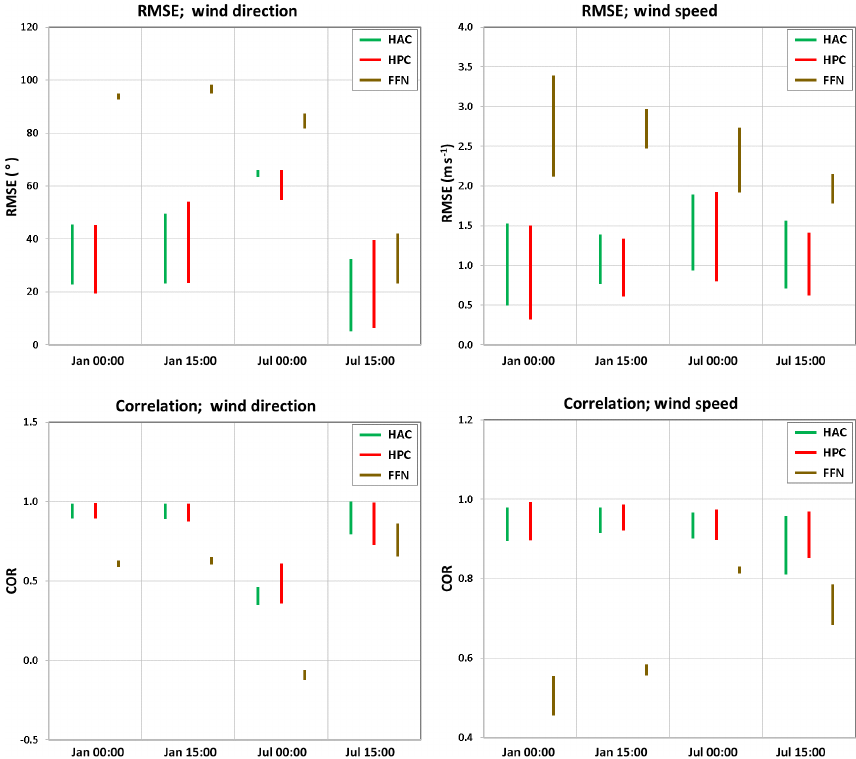
Figure 5. Same as Fig. 3 but for wind direction and wind